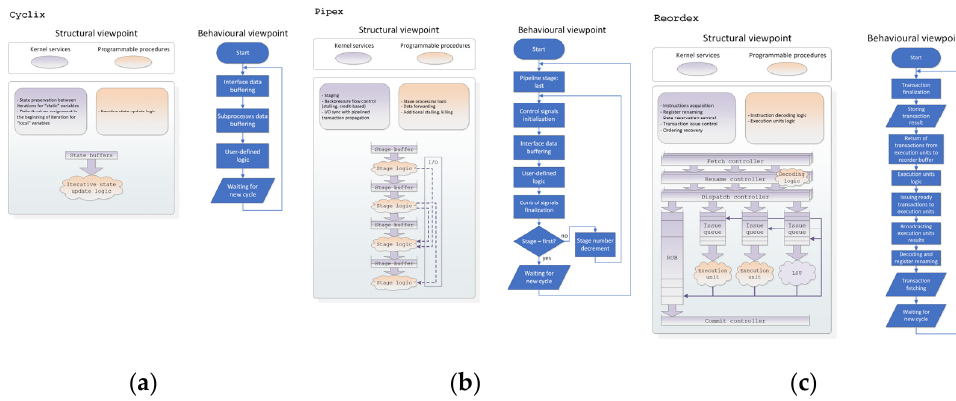
Figure 2. ActiveCore framework architecture.